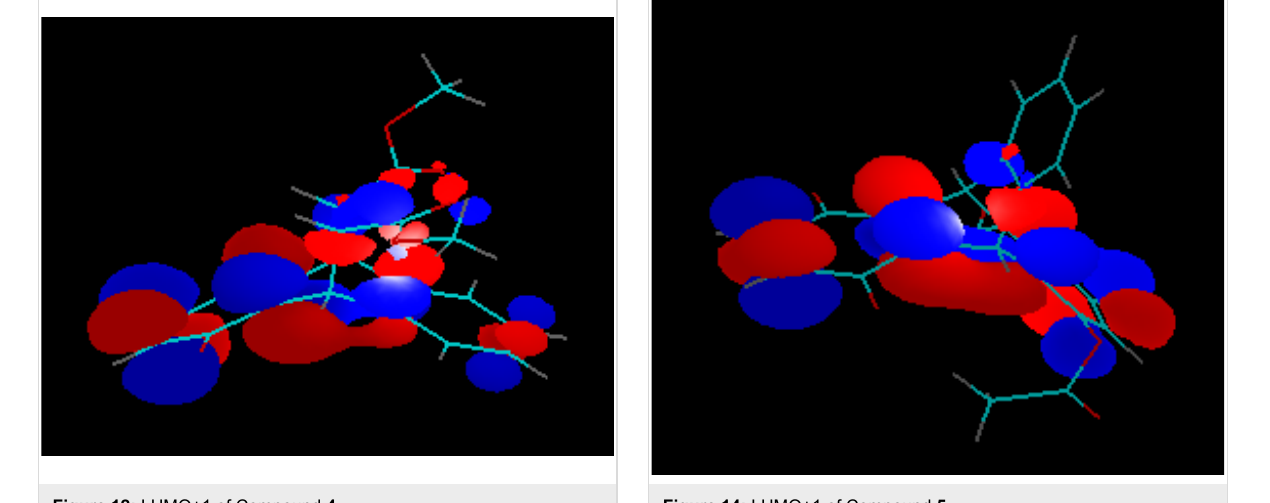
Figure 14: LUMO+1 of Compound 5 .